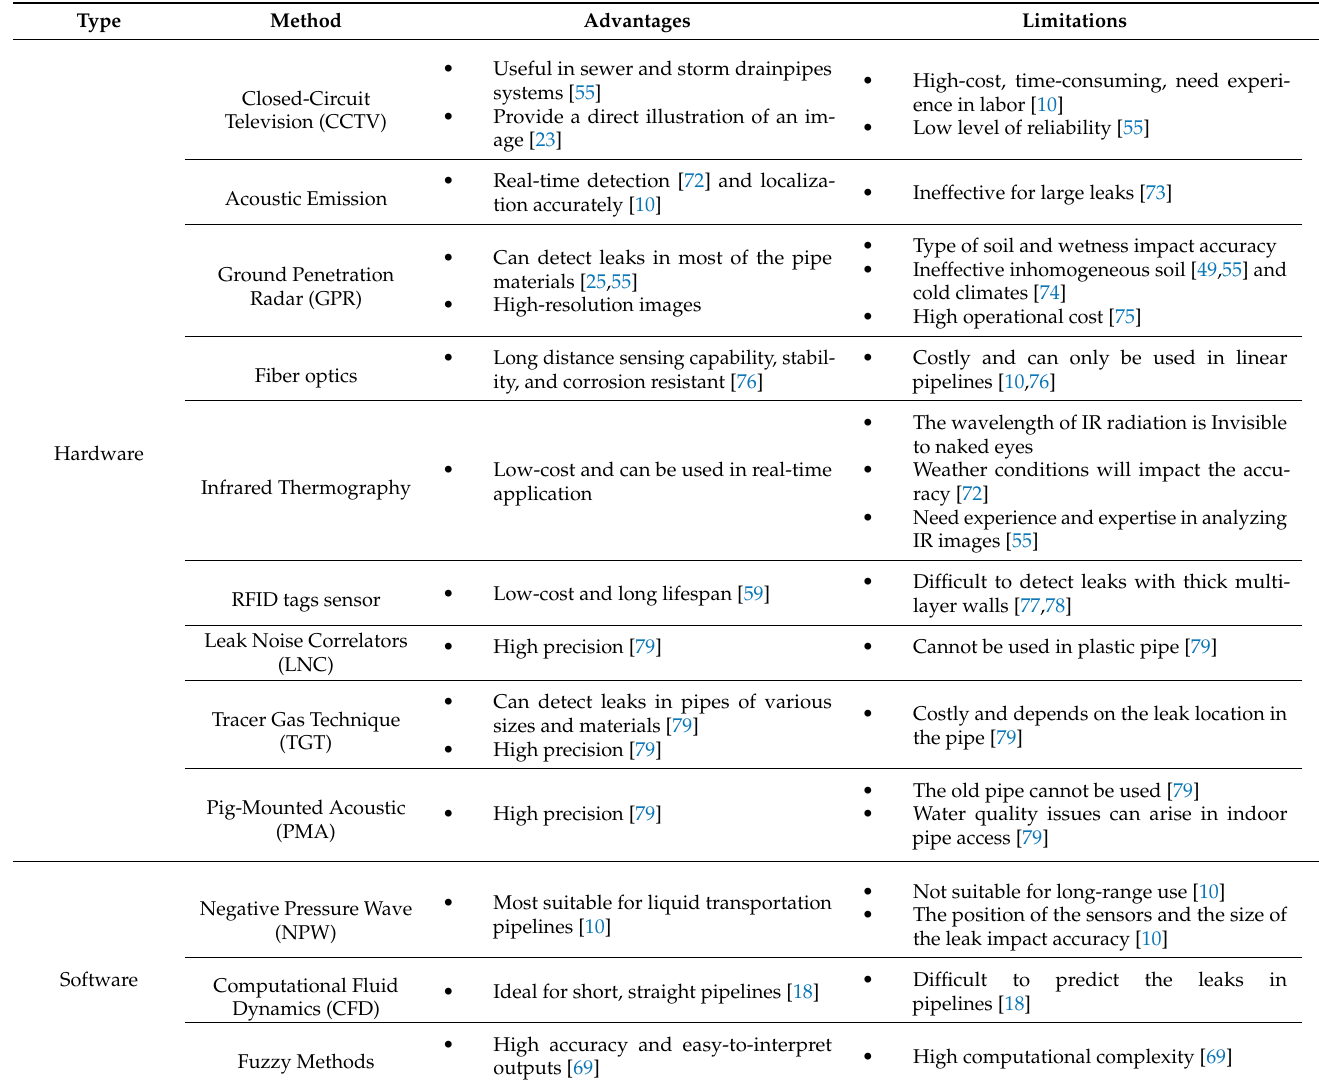
Table 2. Comparison of hardware and software-based methods advantages and